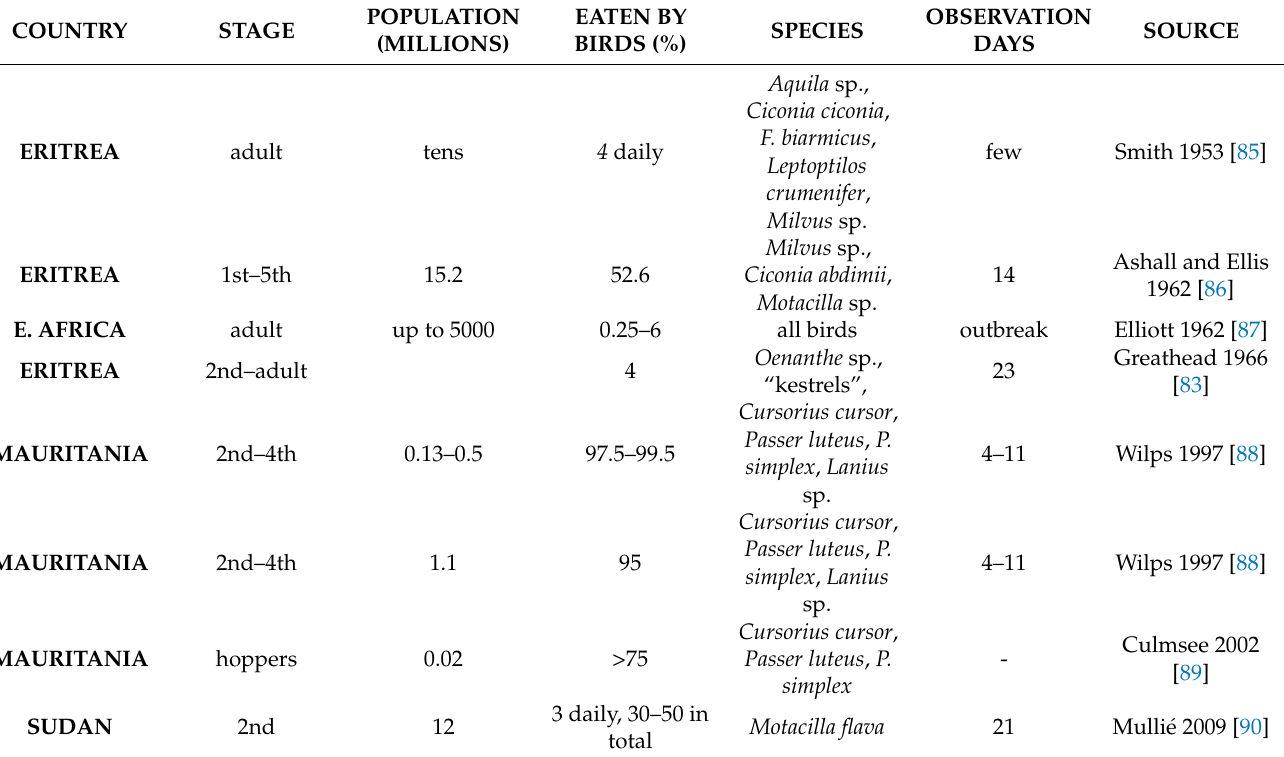
Table 4. Proportion of DL populations eaten by birds in various localities throughout Africa. Smaller hopper populations can be eliminated before last moult by bird